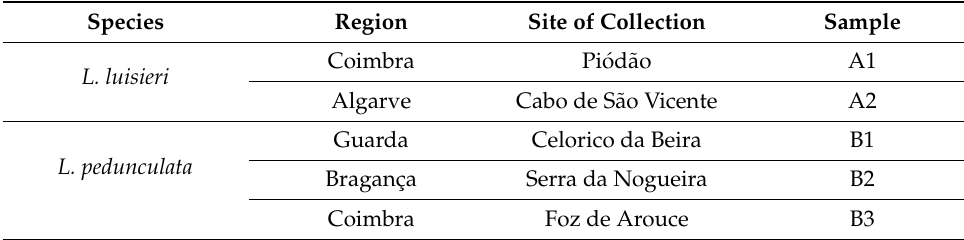
Table 2. Site of collection of Lavandula